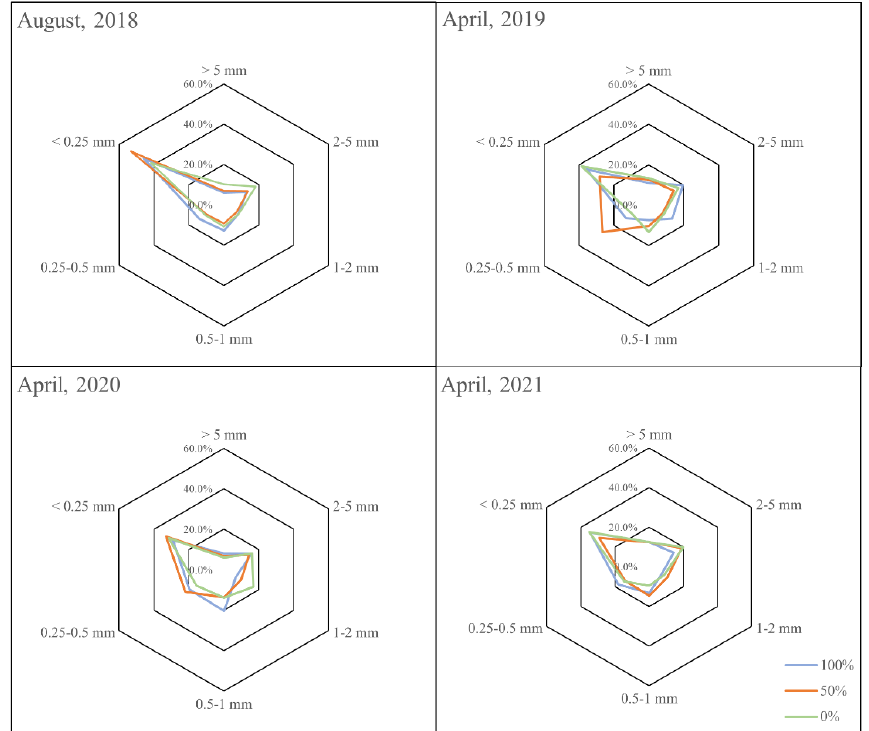
Figure 7. Percentage of TP content of aggregates in different sizes in response to different residue removal rates. The treatments are 0%, 50%, and 100% crop residue removal rates.